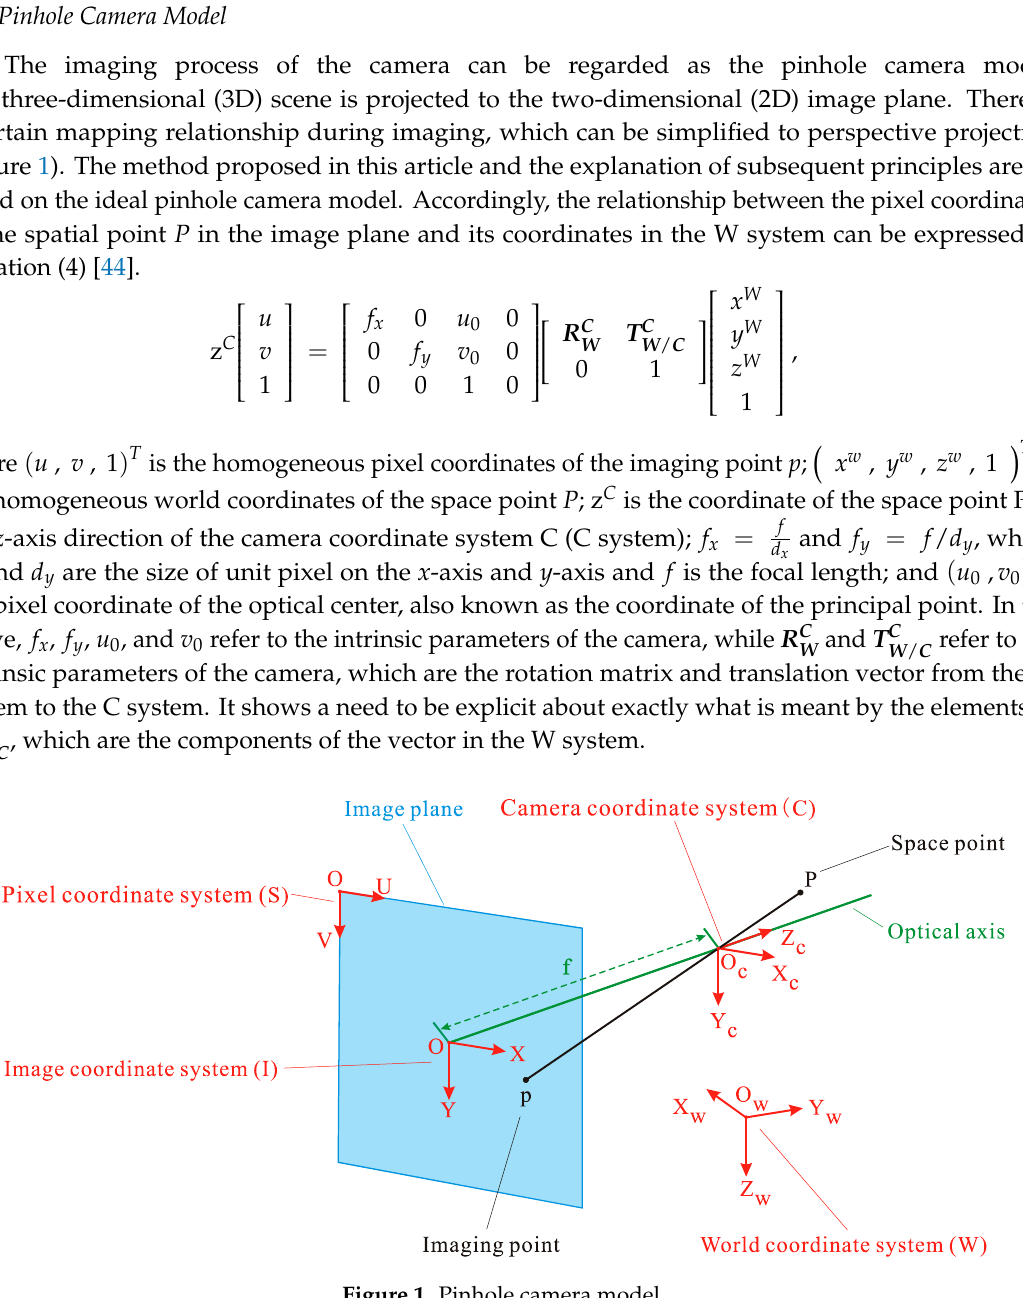
Figure 1. Pinhole camera model.